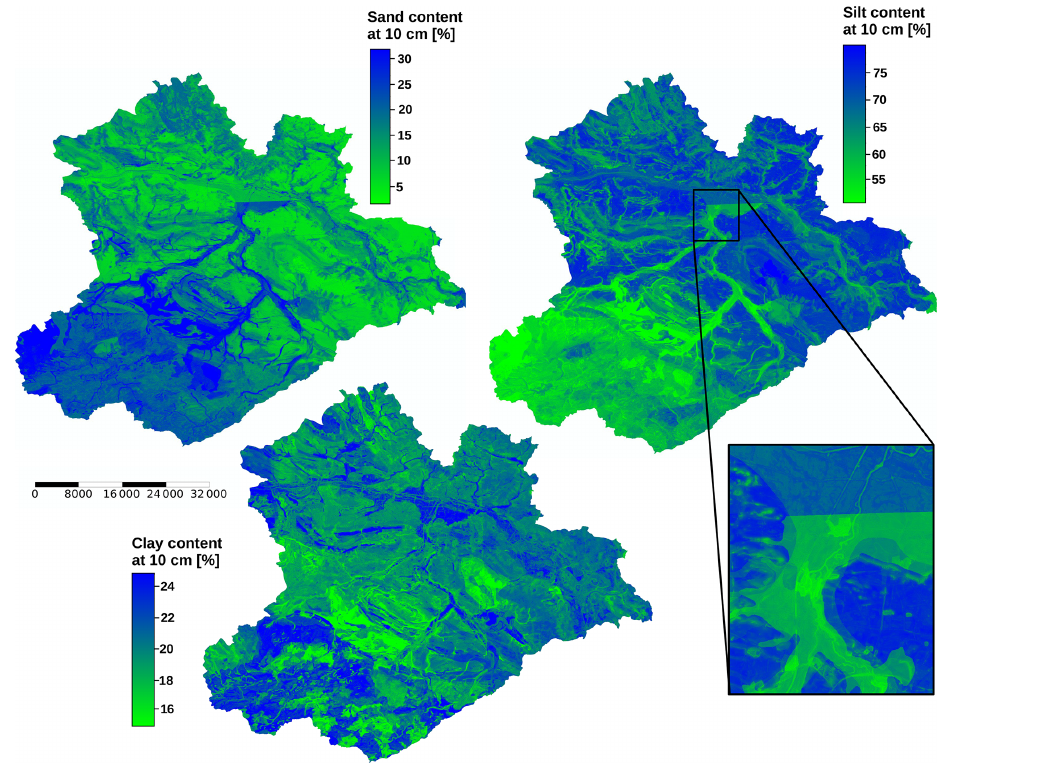
Figure 11. Median of all predictions for sand, silt, and clay content at 10cm depth. The maps show the output of the models built with the predictor set specified in Table 2. The scale bar shows distance in